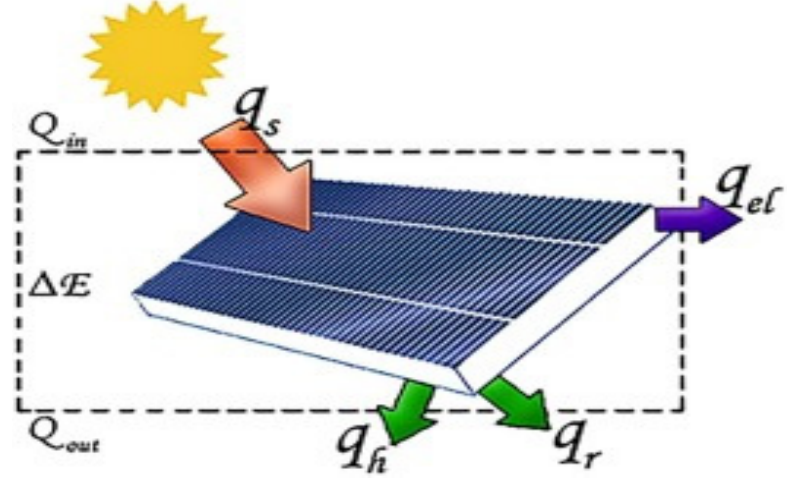
Figure 48. Energy conservation for PV cell [186].